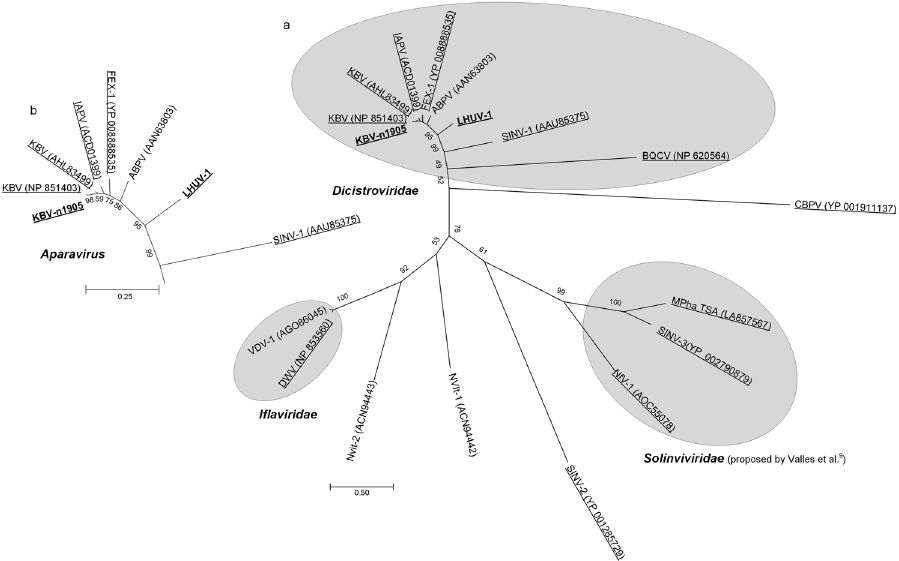
Figure 5. Phylogenetic tree of viruses in ants and other Hymenoptera. The tree ( a ) was inferred using complete Ribosomal dependent RNA polymerase (RdRp) sequences, based on a Le & Gascuel (LG) 54 model with Gamma parameter and invariant sites (LG + G + I) with 500 bootstrap replicates. A TSA that is a putative virus of the ant Monomorium pharoanis 9 was also included. Our sequences are shown in bold text. Taxa found in ants are underlined. GenBank accession numbers are shown in brackets. The inset figure ( b ) shows the Aparavirus genus of Dicistroviridae , with bootstrap support. Solenopsis invicta virus 1,2 and 3 (SINV-1, SINV-2, SINV-3); Formica exsecta virus 1 (FEX-1); Deformed wing virus (DWV); Kashmir bee virus (KBV); Acute bee paralysis virus (ABPV); Black queen cell virus (BQCV); Chronic bee paralysis virus (CBPV); Israeli acute paralysis virus (IAPV); Monomorium pharaonis TSA (Mpha TSA); Varroa destructor virus 1 (VDV-1); Nylanderia fulva virus 1 (NfV-1); Linepithema humile virus 1 (LHUV-1); Nasonia vitripennis virus 1 (Nvit-1); Nasonia vitripennis virus 2